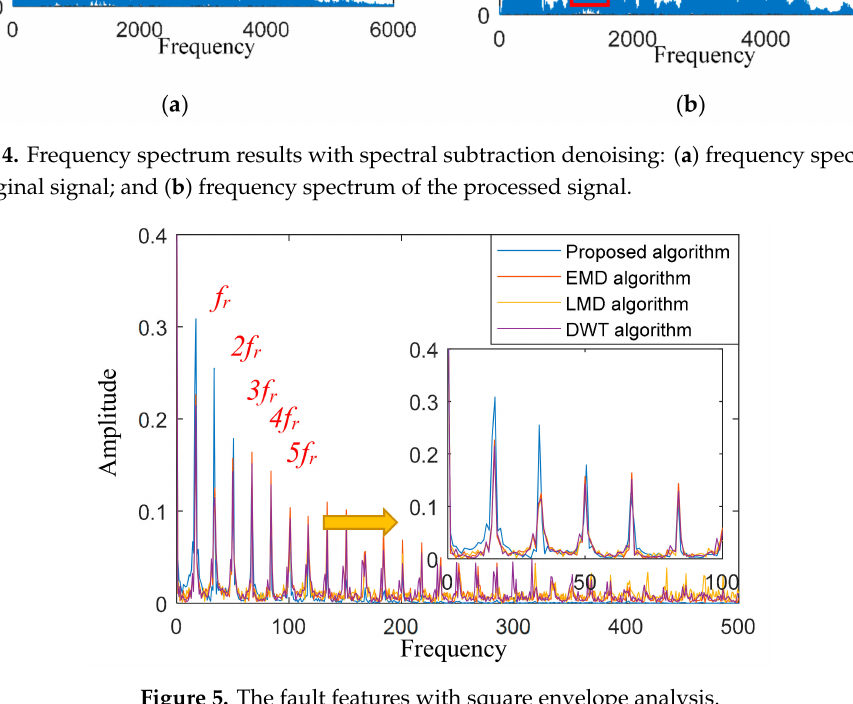
Figure 5. The fault features with square envelope analysis. Table 1. The side-band amplitudes for di ff erent analysis